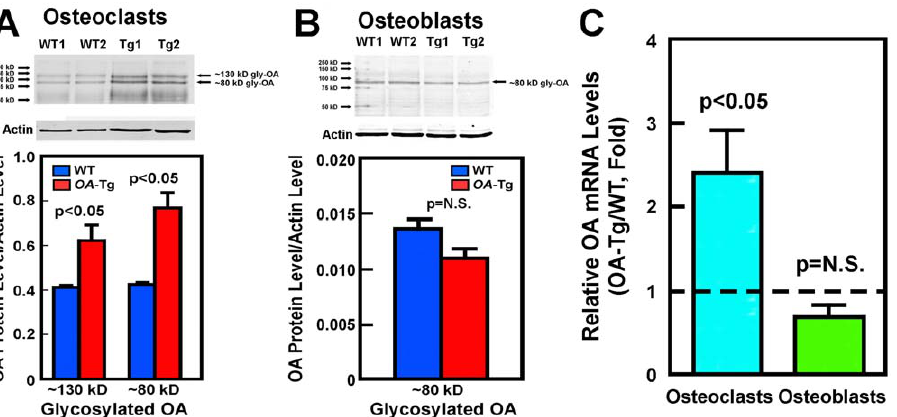
Figure 2. Expression levels of glycosylated OA protein species (A &B) and relative OA mRNA levels (C) in primary marrow-derived osteoclasts and calvaria-derived osteoblasts derived from 4-week-old female OA -Tg mice or WT littermates. A: Top panel shows a representative Western blot of the OA proteins level in osteoclasts from two OA transgenic ( OA -Tg) mice or from two age- and sex-matched WT littermates. Bottom panel summarizes the quantitative analysis of the relative density of the two predominant glycosylated OA protein species, normalized against the density of the corresponding actin protein band (shown as mean 6 SEM). B: Top panel shows the Western blot of the OA proteins level in primary osteoblasts of two OA -Tg mice and two WT littermates. Bottom panel summarizes the quantitative analysis of the relative density of the , 80 kD glycosylated OA protein species (normalized against the density of the corresponding actin band). Results are shown as mean 6 SEM. C: Relative OA mRNA levels in cultured osteoclasts (left bar) and osteoblasts (right bar) of 4 weeks old female OA -Tg mice compared to age- matched female WT mice. Results are shown as mean 6 SEM (n=4 for each).